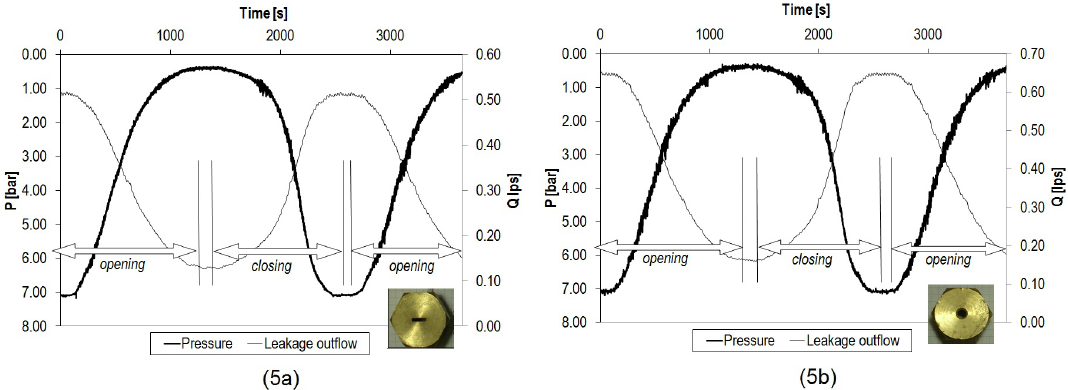
Figure 5. Trend of detected pressures and outflow discharge for a rectangular (a) and a round (b) nozzle.